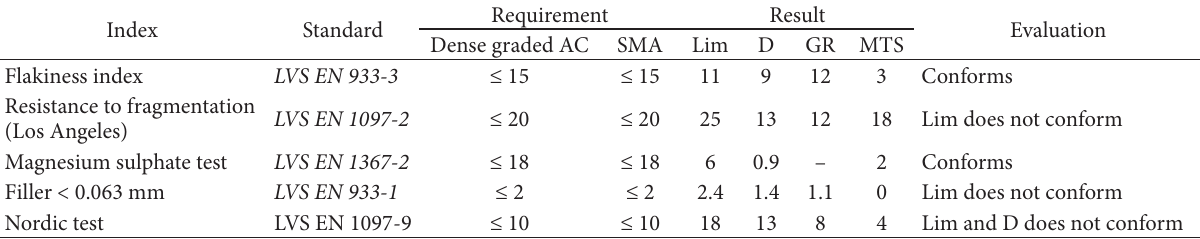
Table 3. Conformity of the coarse aggregate to the requirements of the Roads Specifications 2005 at AADT > 3500 vpd